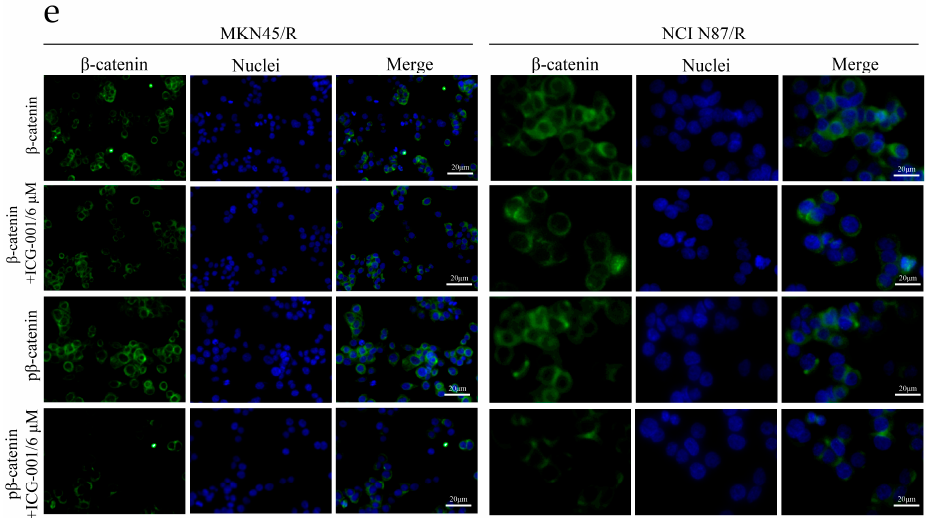
Figure 5. ICG-001 preferentially inhibited cell viability and phosphorylation of β -catenin and induced apoptosis in trastuzumab resistant cells. ( a , b ) Cells cultured for 24 h were either treated with or without ICG-001 at the indicated concentrations or (dimethyl sulfoxide) DMSO, which was set as control. Cell viability was determined by CCK-8 assay 72 h later. Results expressed as % control represented the mean of three experiments. * p < 0.05, ** p < 0.01 vs. controls; ( c ) Cells exposed to ICG-001 for 24 h under different concentrations of (0, 6, 8 μ M) were analyzed by Western blot for full-length PARP and cleaved PARP, with β -actin being a loading control; ( d ) Cells were exposed to ICG-001 for 24 h at the indicated concentrations and with DMSO as control, and cell lysates were probed with phosphor- and total antibodies of β -catenin signaling pathway. β -actin was used as a loading control. The representative images were cropped and shown; ( e ) MKN45/R and NCI N87/R cells were treated with ICG-001 (6 μ M) for 24 h and DMSO as control which was followed by collection for immunofluorescence. Nuclear staining was performed using DAPI (blue), and total β -catenin and phosphor β -catenin were stained by Alexa Fluor ® 488-labeled secondary antibody (green). Slides were imaged using ×20 lens of Leica DMi8 fluorescent microscope.